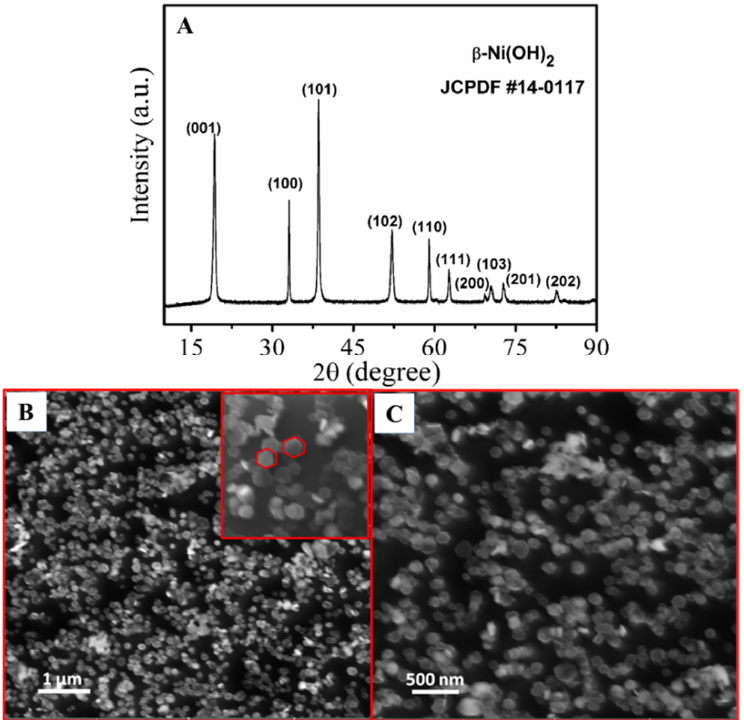
Figure 2. ( A ) XRD patterns of synthesized β‐ Ni(OH) 2 nanoplates; ( B , C ) FESEM images of β‐ Ni(OH) 2 nanoparticles at different magnifications.